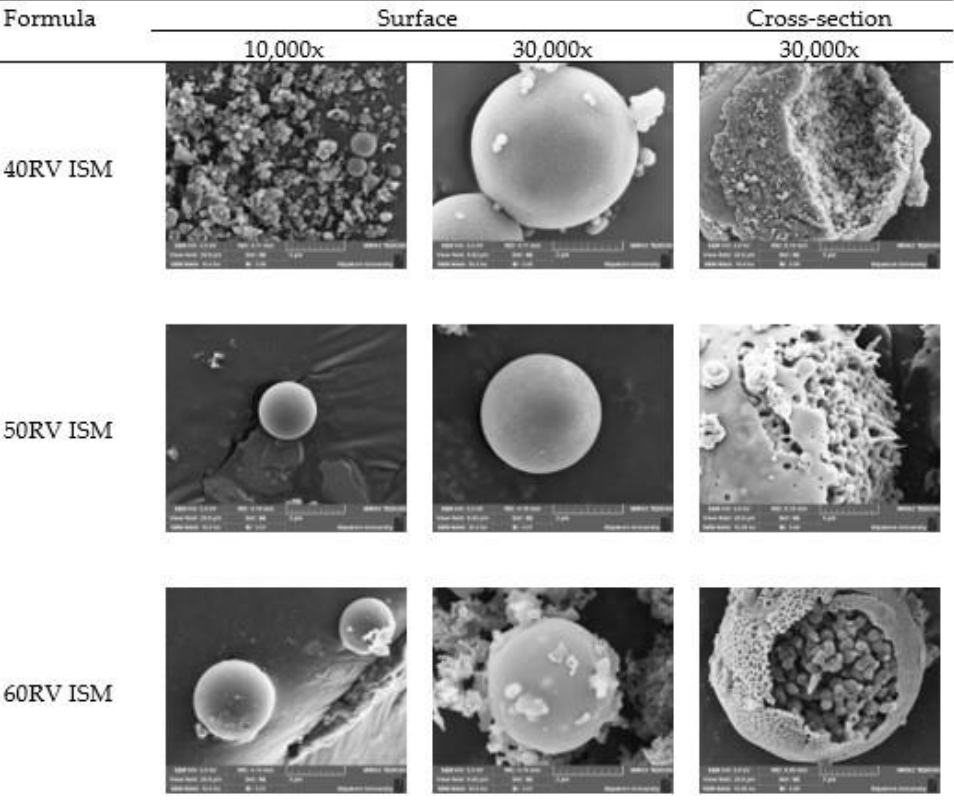
Figure 7. SEM micrographs of the surface and cross-section of the vancomycin HCl-loaded ISM formulations at 10,000× and 30,000×.